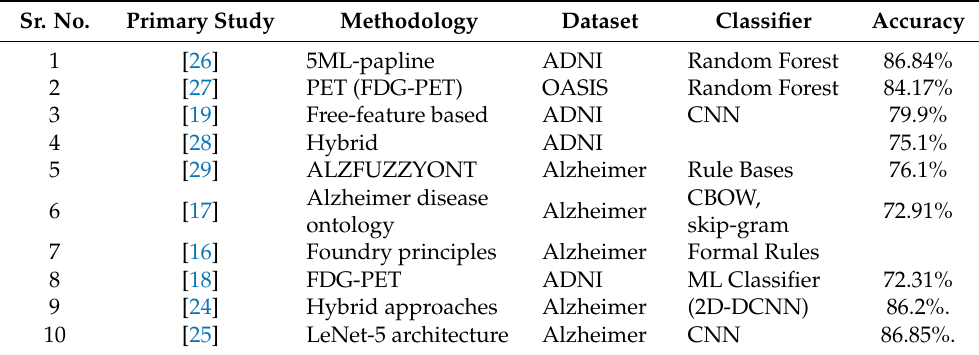
Table 1. Comparison of Existing Relevant Approaches. Sr.